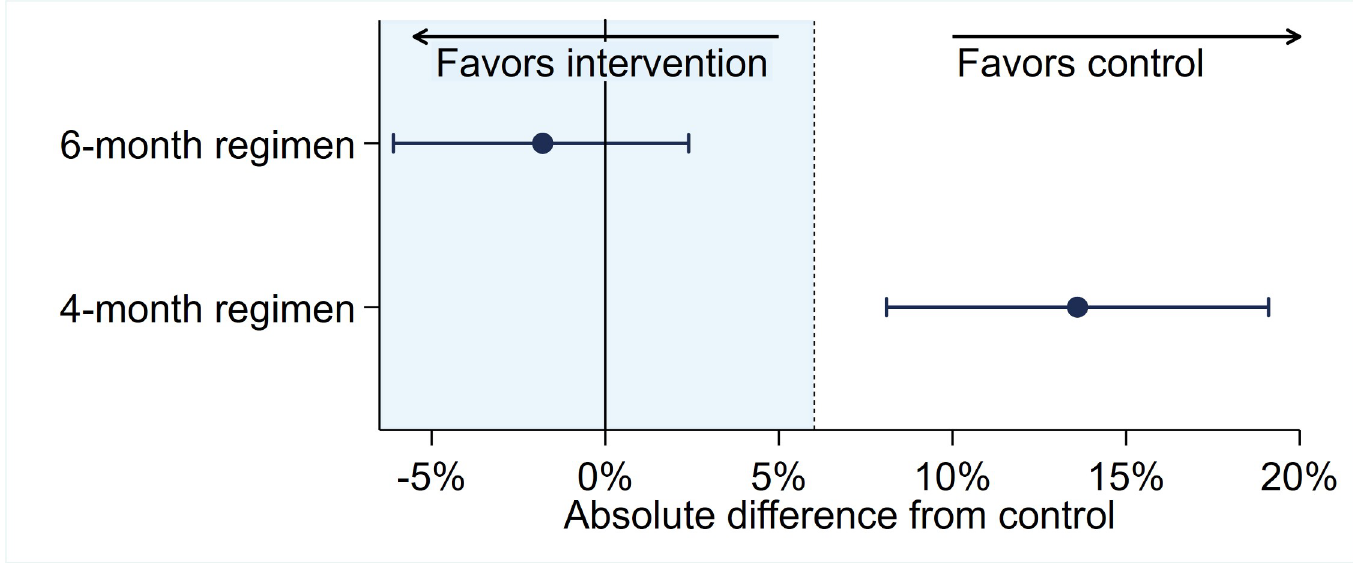
Fig 1. Illustration of the results of a noninferiority trial with a 6% margin of noninferiority (represented by the shaded area to the left of 6%), data from the RIFAQUIN trial [5]. The findings for two drug regimens are illustrated by point estimates of efficacy surrounded by 90% confidence intervals from the per protocol analysis. In this example, the 6-month regimen is noninferior to control because the upper bound of the confidence interval is less than the 6% margin of noninferiority. However, the 4-month regimen is not noninferior to the control because the upper bound exceeds the margin of noninferiority.